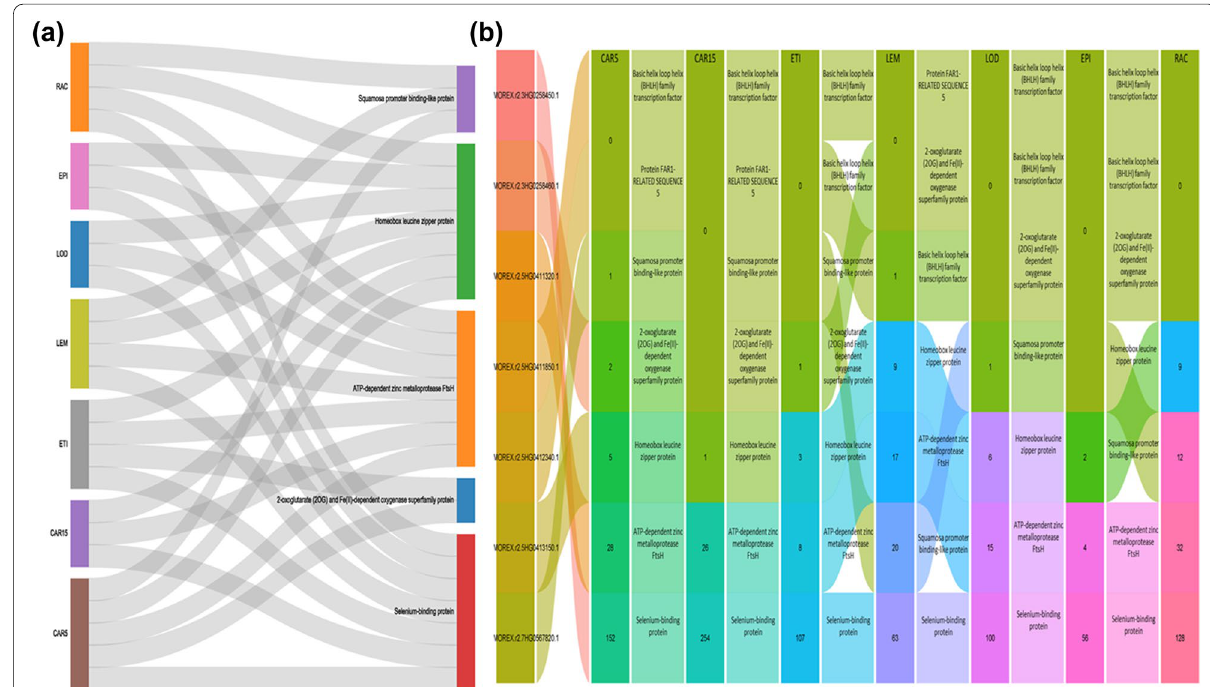
Fig. 8 Expression pattern of the candidate genes in different barley grain related‑organs at different developmental stages. The connection of the candiate genes with the grain organs showed in a while the expression level and pattern has been shown as alluvial plot in